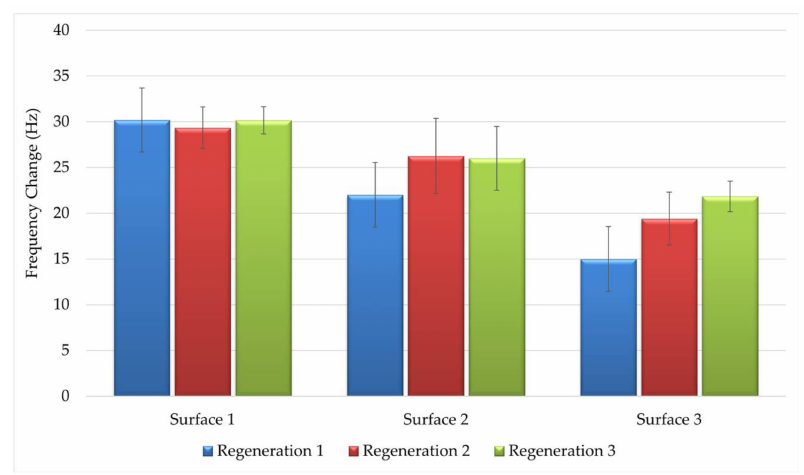
Figure 4. Regeneration of different OTA-immobilized sensor surfaces with 50 mM NaOH and 1% SDS regeneration solution. Error bars represent standard errors. Each experiment was repeated three times.